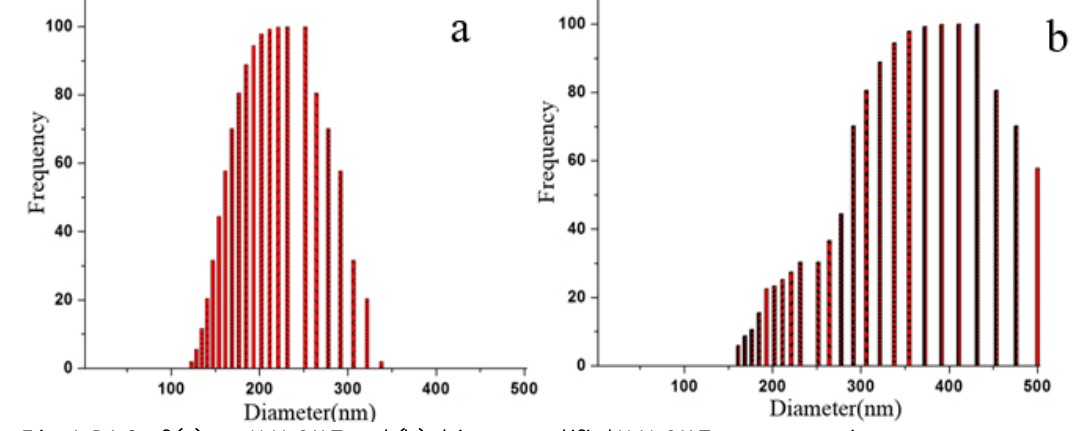
Fig. 4. DLS of (a) raw MWCNT and (b) chitosan-modified MWCNT